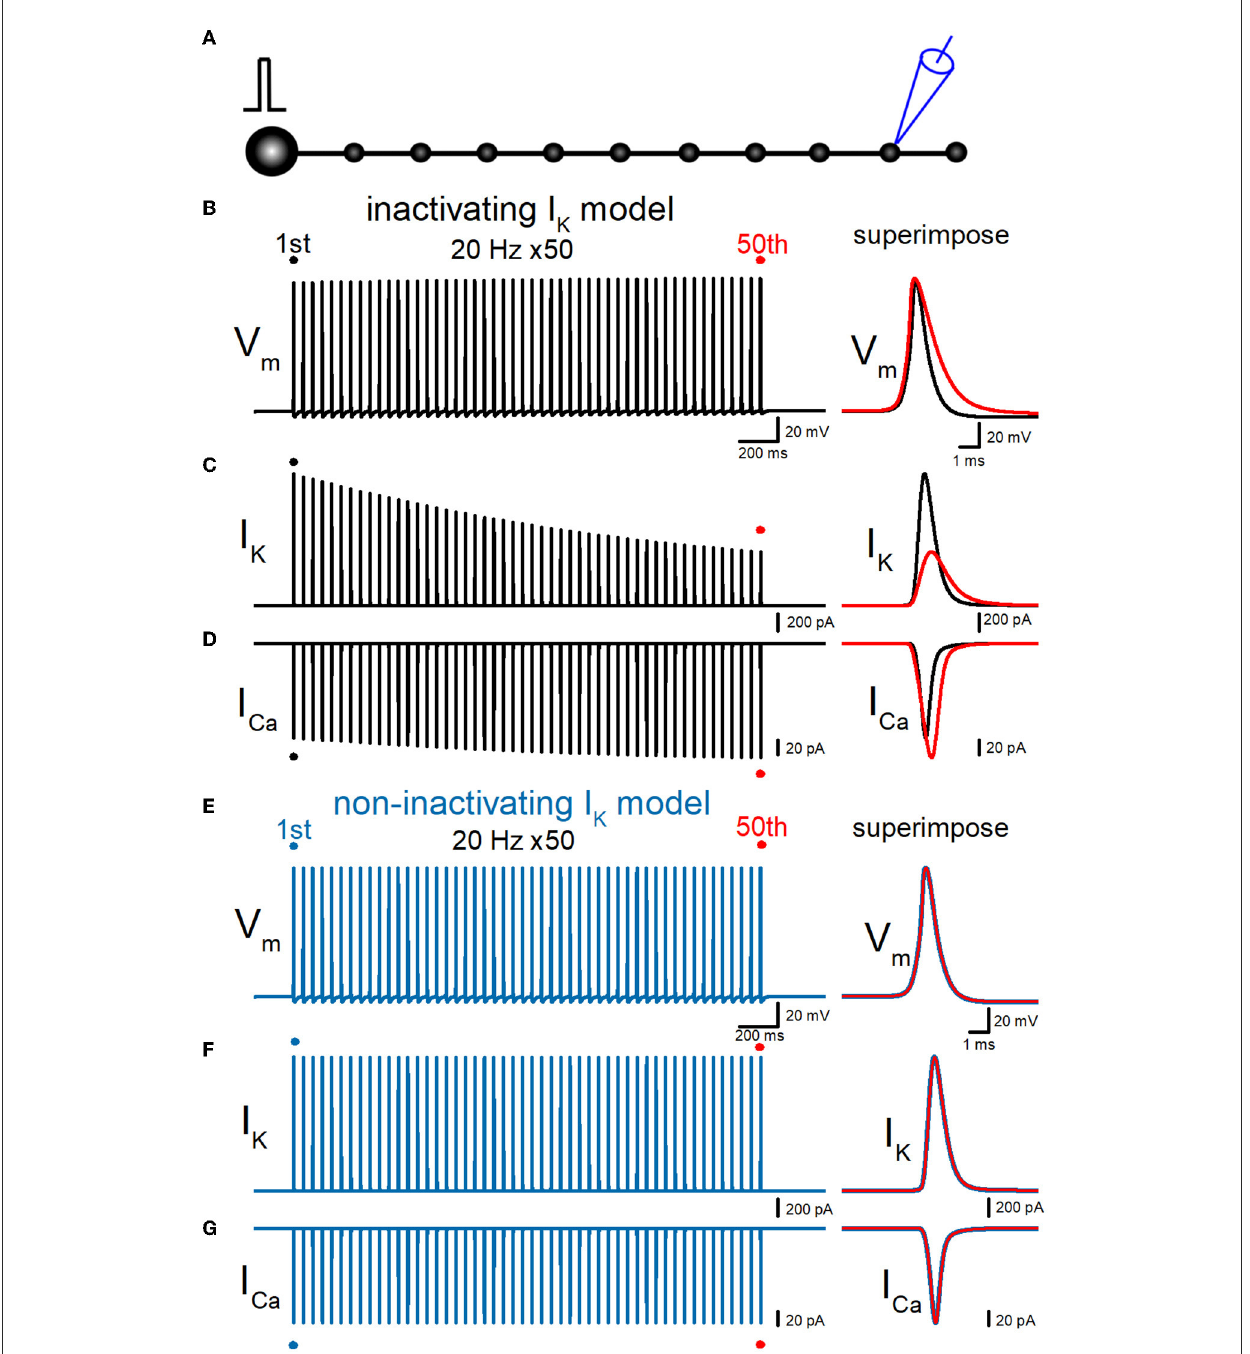
FIGURE6 Effects of repetitive stimuli on action potentials, axonal I K , and presynaptic I Ca recorded from the en passant boutons. (A) Schematic drawing of the multi-compartment model of the granule cell and mossy fiber and the recording site at the ninth en passant boutons. (B) Simulated propagating action potentials at the mossy fiber bouton (V m ) elicited by repetitive stimuli of 50 times at 20Hz in the inactivating I K model. (C) Axonal K + current elicited by the repetitive action potentials (I K ) in inactivating I K model. (D) Ca 2 + currents (I Ca ) elicited by axonal action potentials during the repetitive stimuli in inactivating the I K model. (E) Simulated propagating action potentials at the mossy fiber bouton (V m ) elicited by repetitive stimuli of 50 times at 20Hz in the non-inactivating I K model. (F) Axonal K + current elicited by the repetitive action potentials (I K ) in the non-inactivating I K model. (G) Ca 2 + currents (I Ca ) elicited by axonal action potentials during the repetitive stimuli in the non-inactivating I K model. In each right panel, the responses to the 50th stimulus (red traces) were superimposed with that elicited by the 1st stimulus (black or blue traces) for comparison.